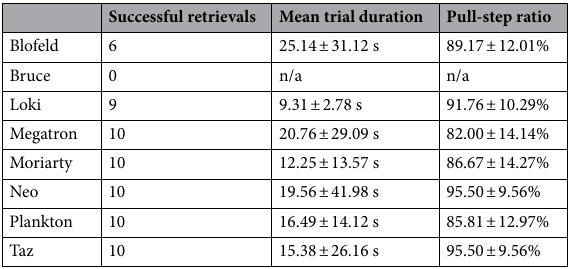
Table 2. Individuals’ performance in Experiment 2, namely: the number of successful retrievals performed, the average time taken to retrieve the token across all of their successful trials, and each individual’s pull-step ratio across all their successful trials.